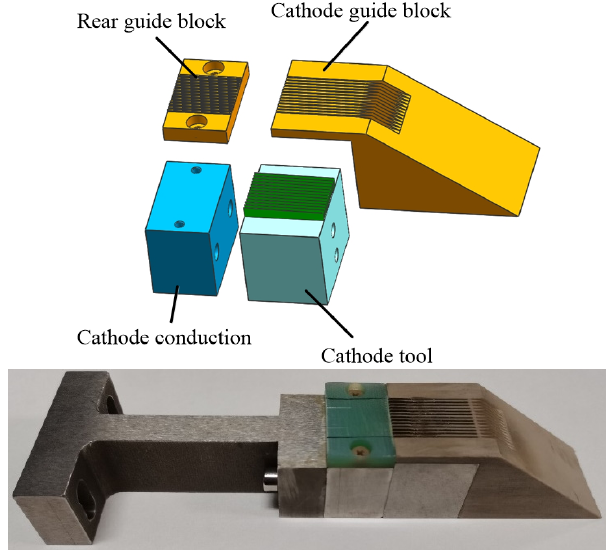
Figure 9. ECB cathode tool model assembly.